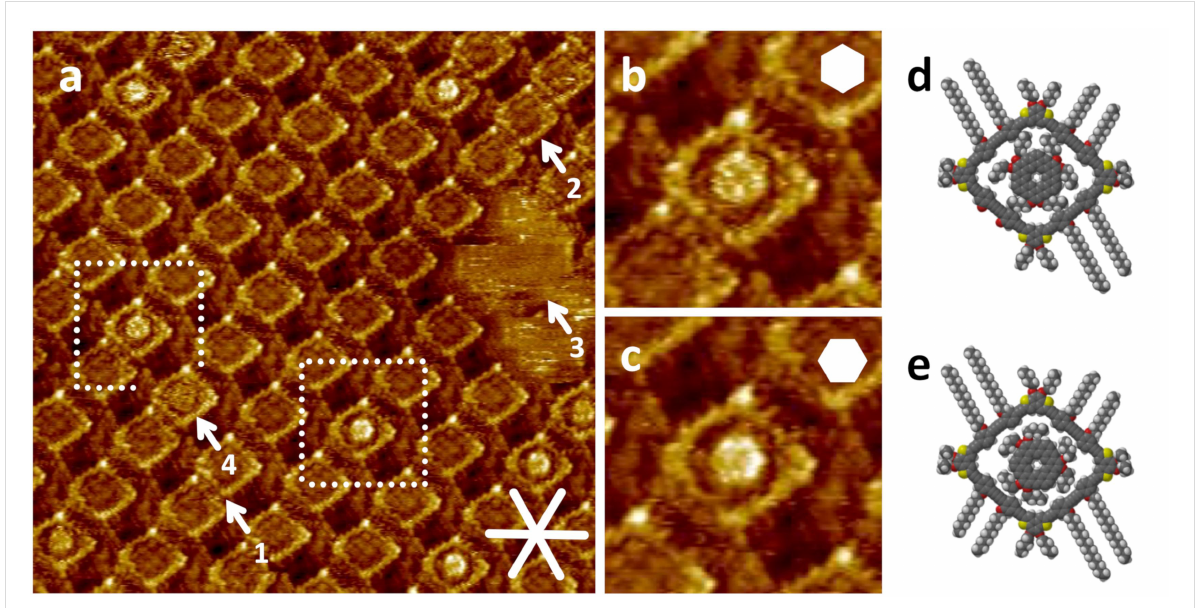
Figure 3: (a) Overview scanning tunneling microscopy image of a nanopattern of 1a with intermolecularly intercalated 2 at the TCB/HOPG interface, (b)–(c) enlarged cutouts of the marked regions of (a), and (d)–(e) molecular models of the structures observed in (b) and (c). Image parameters and sample preparation: (a) 1 µL c ( 1a ) = 5 × 10 − 7 M (thermally annealed for 20 s at 80 °C), and 1 µL c ( 2 ) = 1 × 10 − 6 M added at rt; V S = − 0.7 V, I t = 49 pA; 39.5 × 39.5 nm 2 ; (b) and (c): 8.7 × 8.7 nm 2 . White lines indicate the HOPG main axis directions.